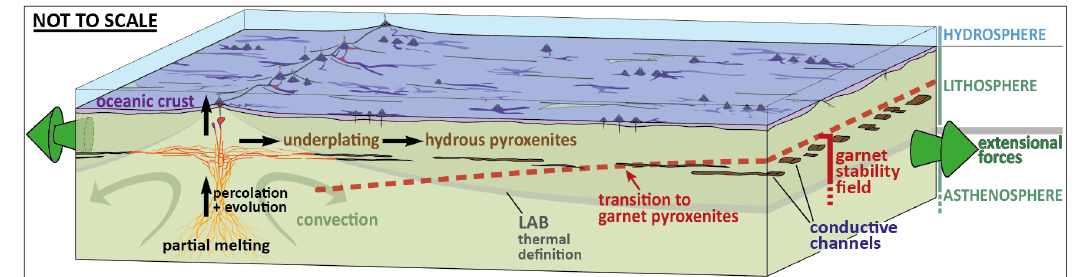
Figure 9. Simplified diagram highlighting the expected geometry of the fossilized channels. This model presents an interpretation slightly different from the one proposed in Figure 8c. Here the deep pyroxenites are subhorizontal from the moment of their formation and limited to a narrow depth window, which corresponds to the depth where interconnected melt has been detected. Contrastingly, in Figure 8c, off-axis shearing is proposed to impact the depth of the pyroxenite channels.